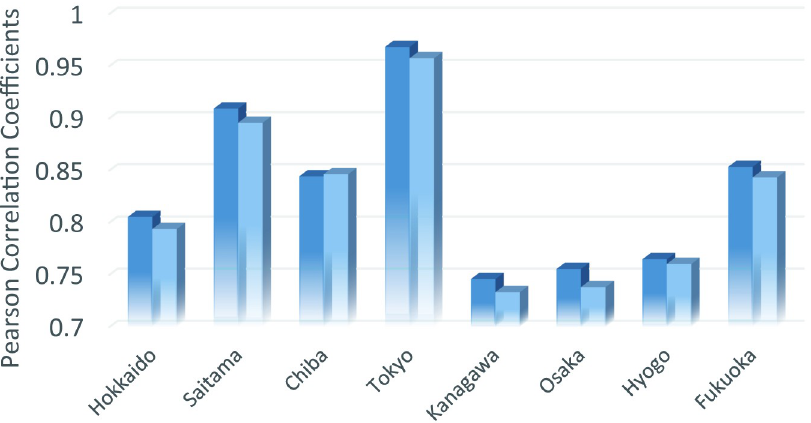
Fig 3. Pearson correlation coefficients between effective reproduction numbers (R(T)) and the measure of potential contacts ( PC ð T (cid:0) 5 Þ ) in the business and commercial district (applied to the daily data set from April 1 to May 6, 2020).